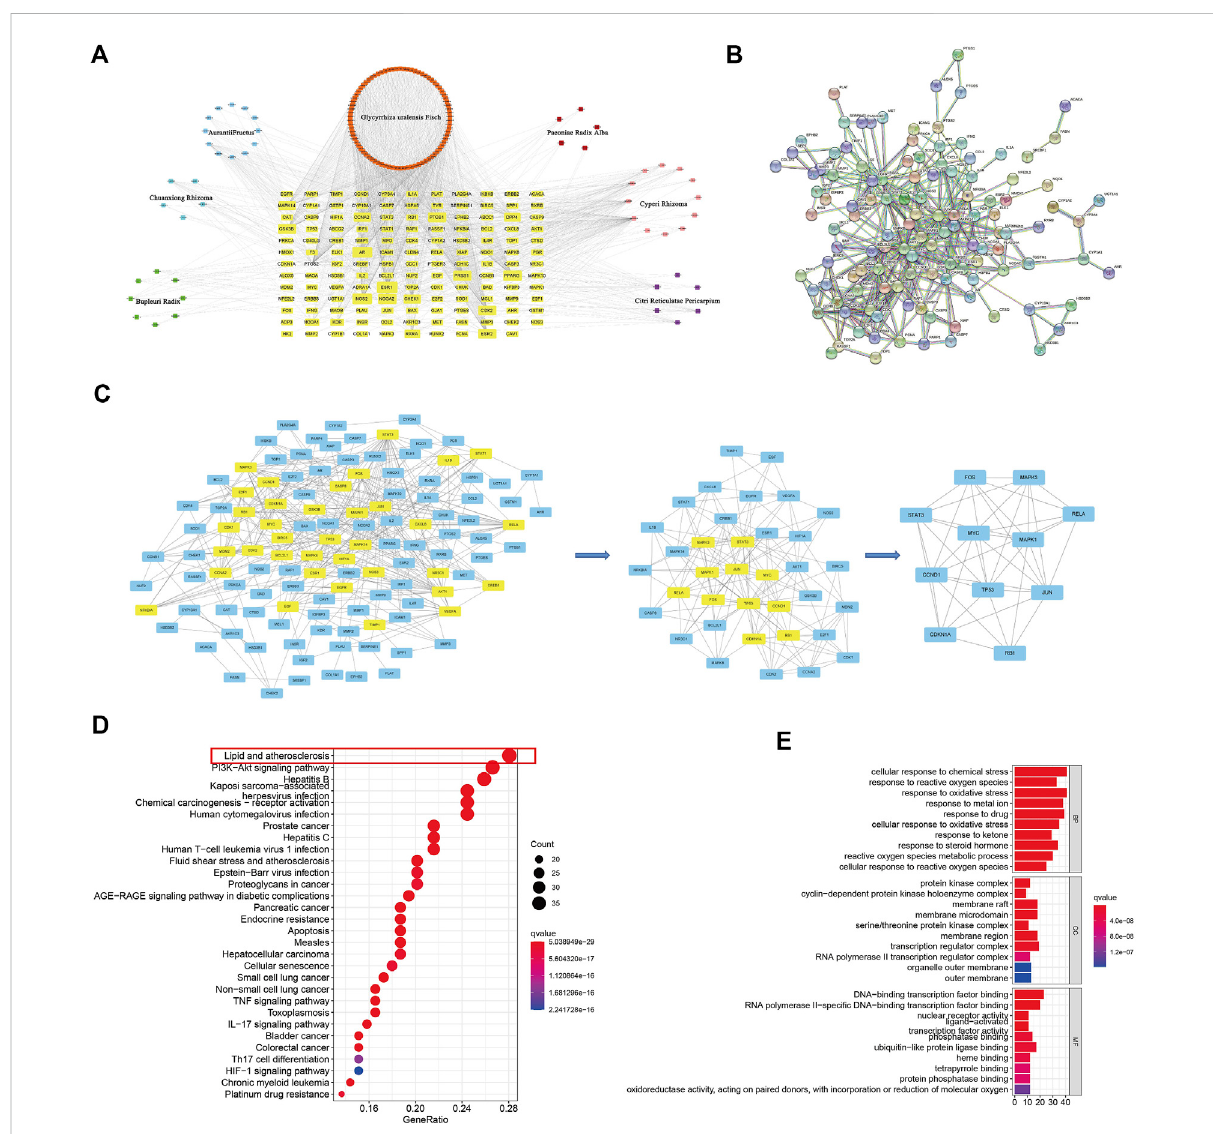
FIGURE 2 NetworkpharmacologyscreenedthepotentialingredientsandthetargetsofCSSagainstPCa. (A) Dispersionmapofcomponent-targetofCSS. Square represents active components of each Chinese materia medica; Yellow node represents target of chemical composition action; Each side represents interaction between the molecule of compounds and targets; There were 142 common targets. (B) The PPI network of the CSS compounds and PCa-related targets from this 142 common targets. (C) The twice analysis of PPI network got 11 nodes and 82 edges. (D) The KEGG pathways analysis and (E) GO